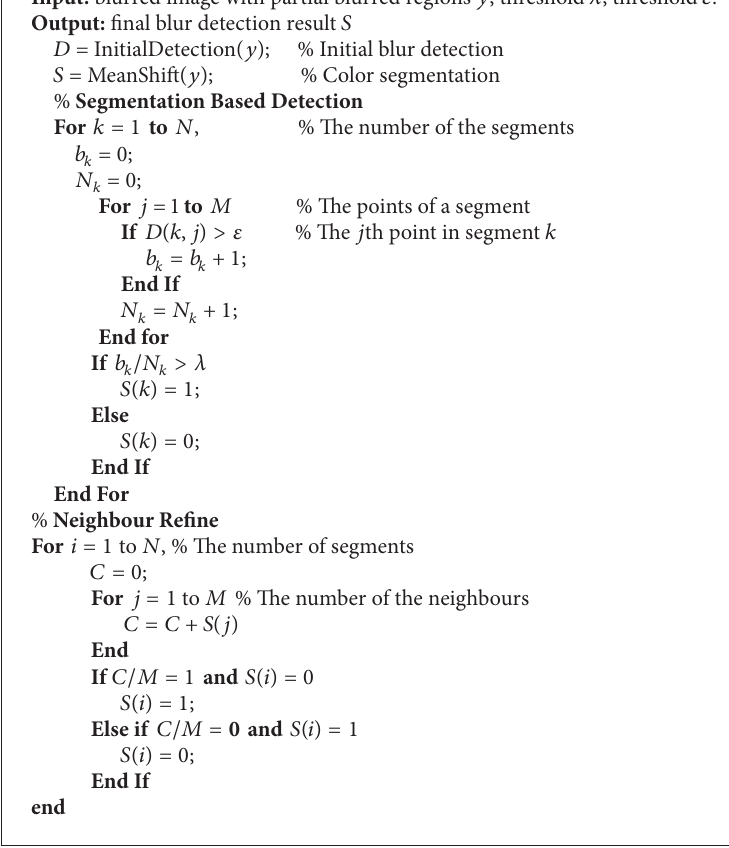
Algorithm 1: Blur detection algorithm.